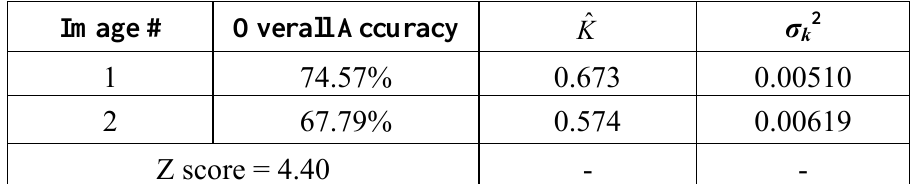
Table 1C. Accuracy assessment for classification the results in Tables 1A and